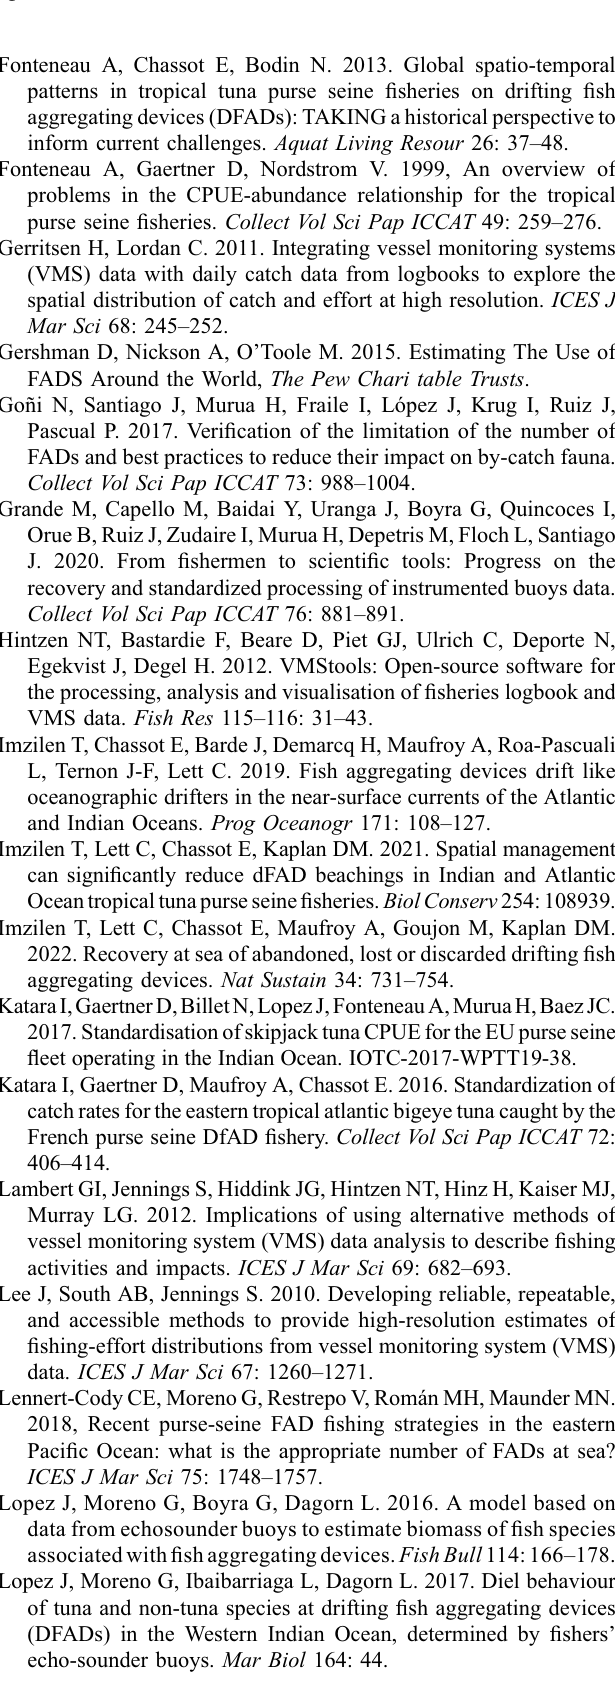
Table 1: Standard data format for buoy location